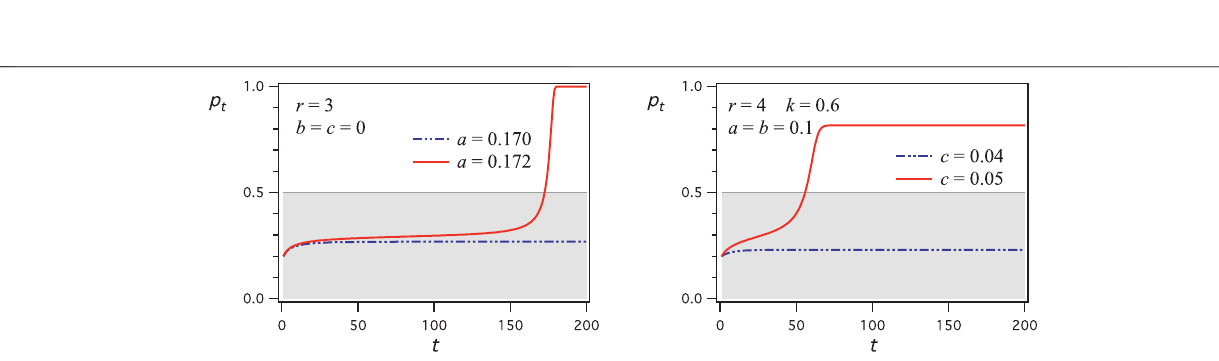
FIGURE3|Left: evolutionoftheproportionofAsupport P { 4 } 0 . 20 , 0 , 0 , 1 ( p ) asafunctionof p .ThearrowsshowthespeedingupoftheAminorityspreadingstartingfrom an initial support p (cid:2) 0 . 25. Right: evolution of the proportion of A support P { 4 } 0 , 0 . 2 , 0 , k ( p ) as a function of p . The arrows show the A minority now shrinking from an initial support p (cid:2) 0 .